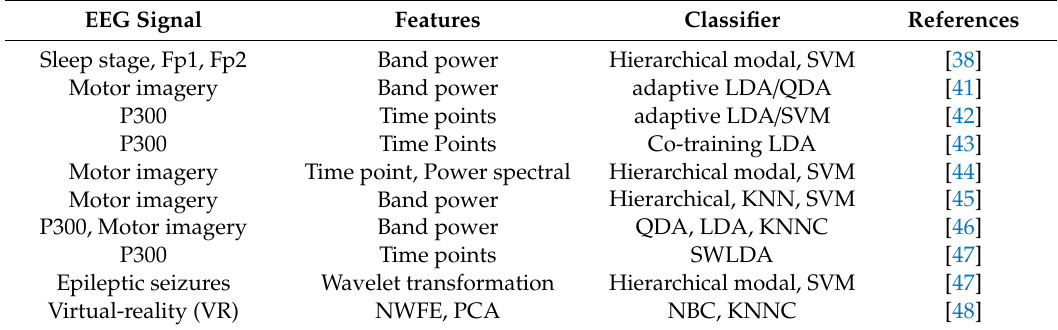
Table 4. Descriptions of the EEG-P300 classification method found in the latest literature